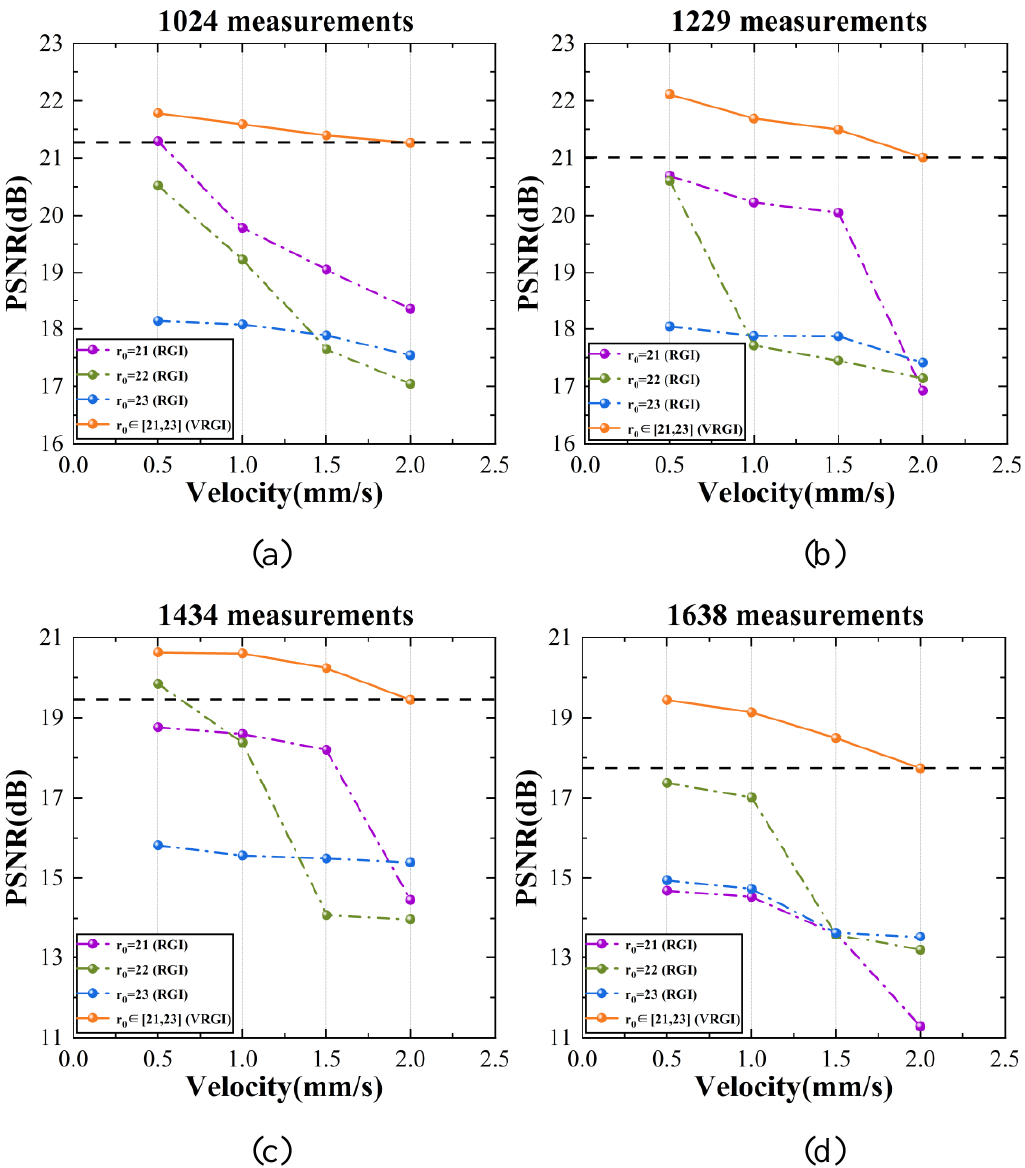
Figure 3. PSNR values of RGI and VRGI images: ( a ) PSNR of RGI and VRGI images at different velocities with 1024 measurements; ( b ) PSNR of RGI and VRGI images at different velocities with 1229 measurements; ( c ) PSNR of RGI and VRGI images at different velocities with 1434 measurements; and ( d ) PSNR of RGI and VRGI images at different velocities with 1638 measurements.